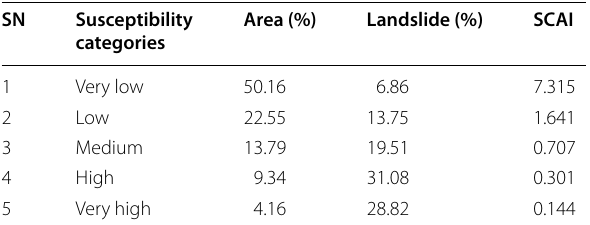
Table 3 Distribution of landslide and SCAIs in the